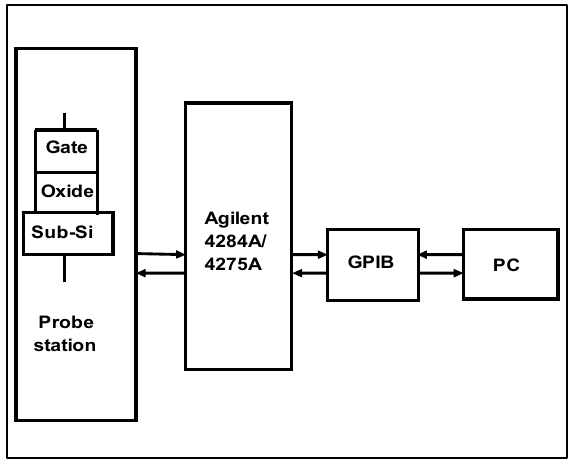
Figure 1. Capacitance-voltage (C-V) measurement system of metal-oxide-semiconductor (MOS) devices. A MOS device was located on the manual probe station which was connected to the LCR meters (Agilent 4284A/4275A). The LCR meters were controlled by a desktop computer through a GPIB interface. The C-V measurement data extracted from the LCR meters were transferred back to the computer and saved to obtain the C-V curves